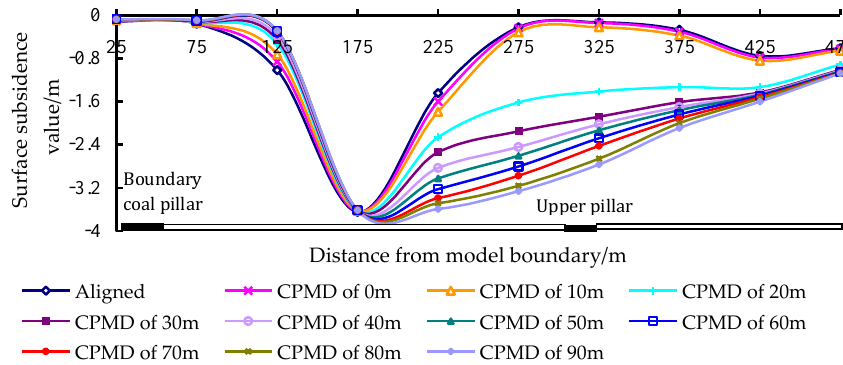
Figure 12. Surface subsidence curves vs. CPMD.